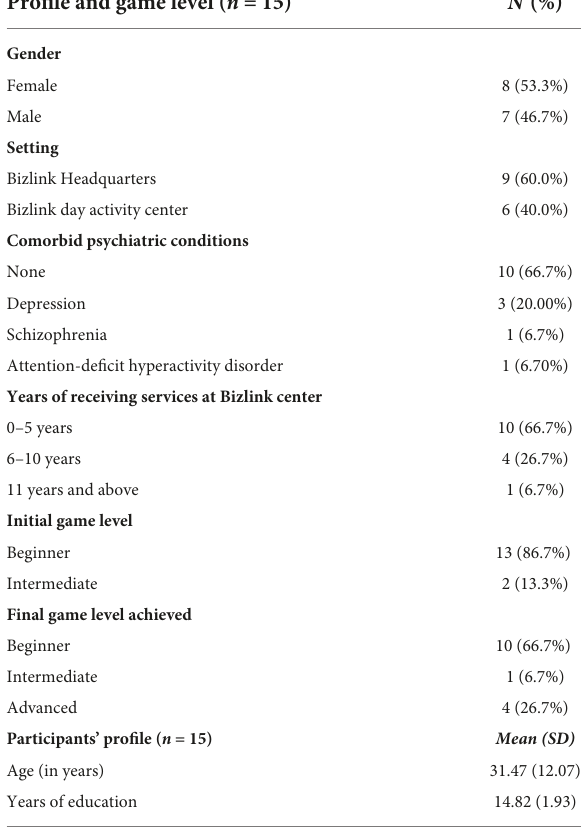
TABLE 1 Participants’ demographic profile and game